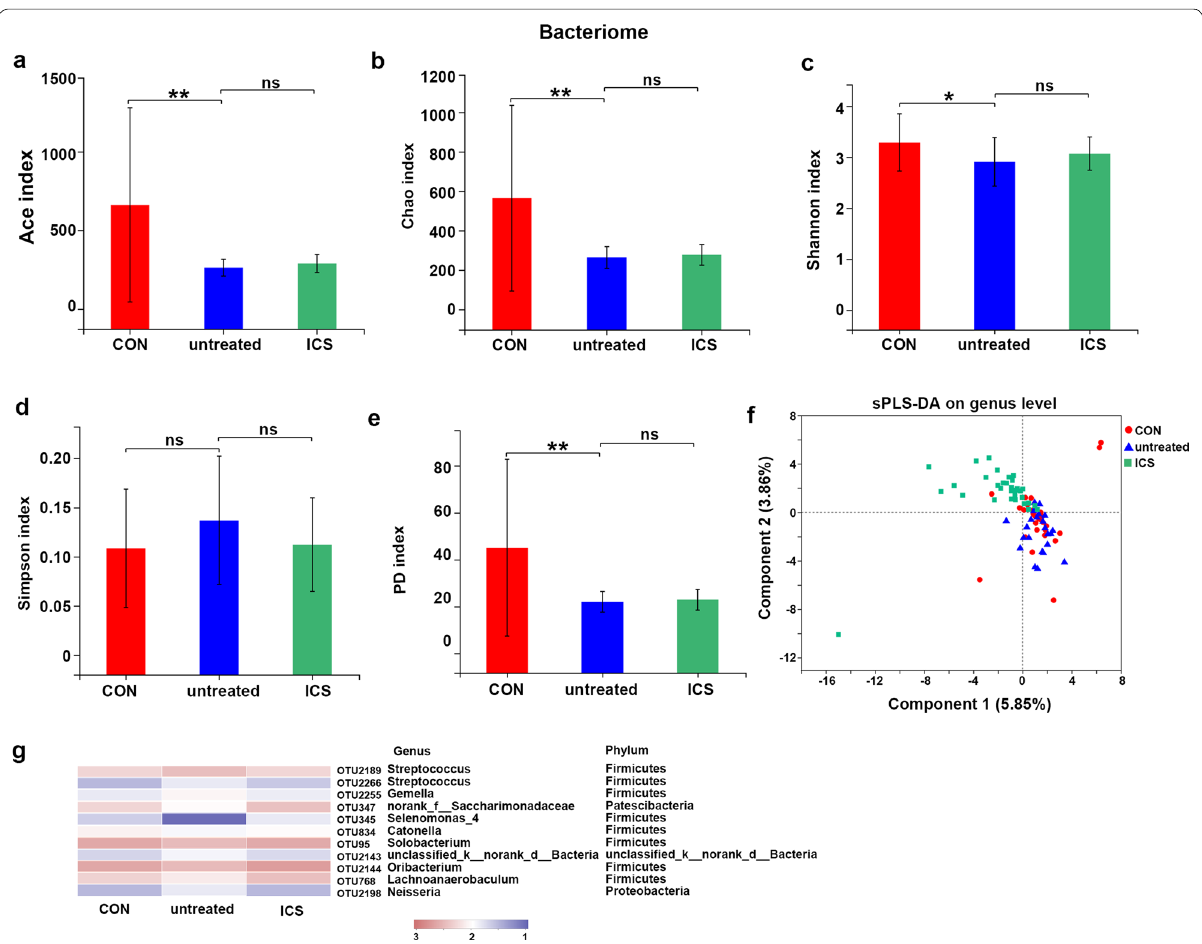
Fig. 4 α and β diversity of the airway bacteriome. a , b Bacteriome richness as indicated by Ace and Chao indices. c – e Shannon, Simpson and PD indices in each group. Statistical significance was determined using Kruskal–Wallis rank-sum test.